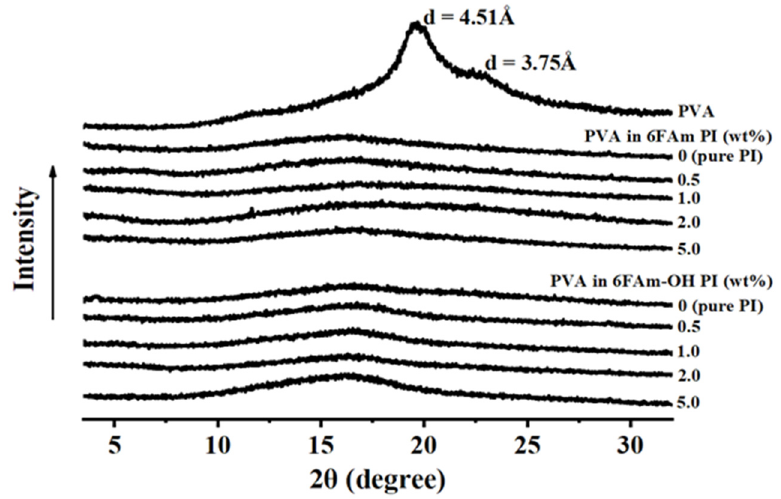
Figure 5. Wide-angle X-ray patterns of CPI membrane films with various PVA contents.